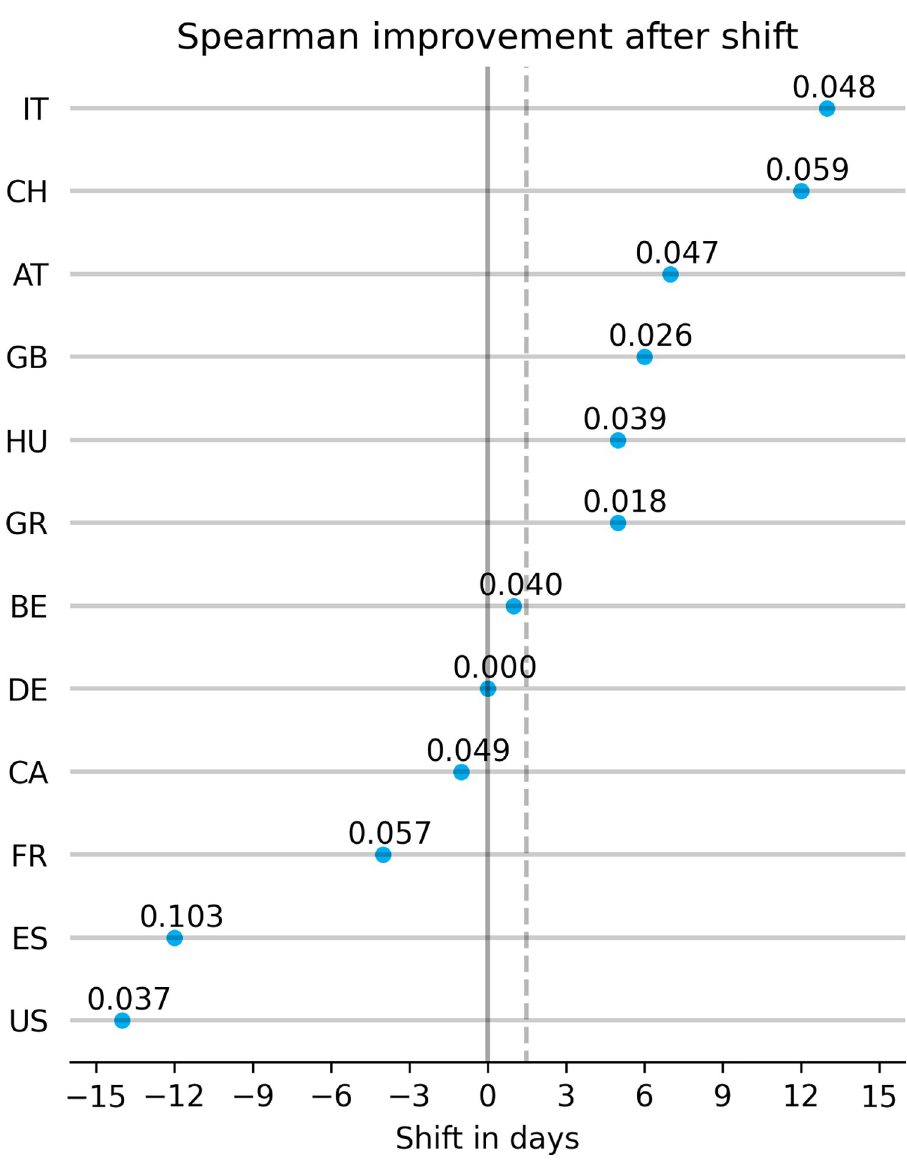
Fig 2. Shift correlation analysis between COVID-19 cases and Symptoma risk assessment. The x-axis shows the days the Symptoma time series shifted to reach the maximum correlation. The numbers above the markers show the improvement in correlation with the introduction of a shift. Only countries with a shift within the range [–15, 15] were included in this figure. The dashed grey line represents the mean at 1.5